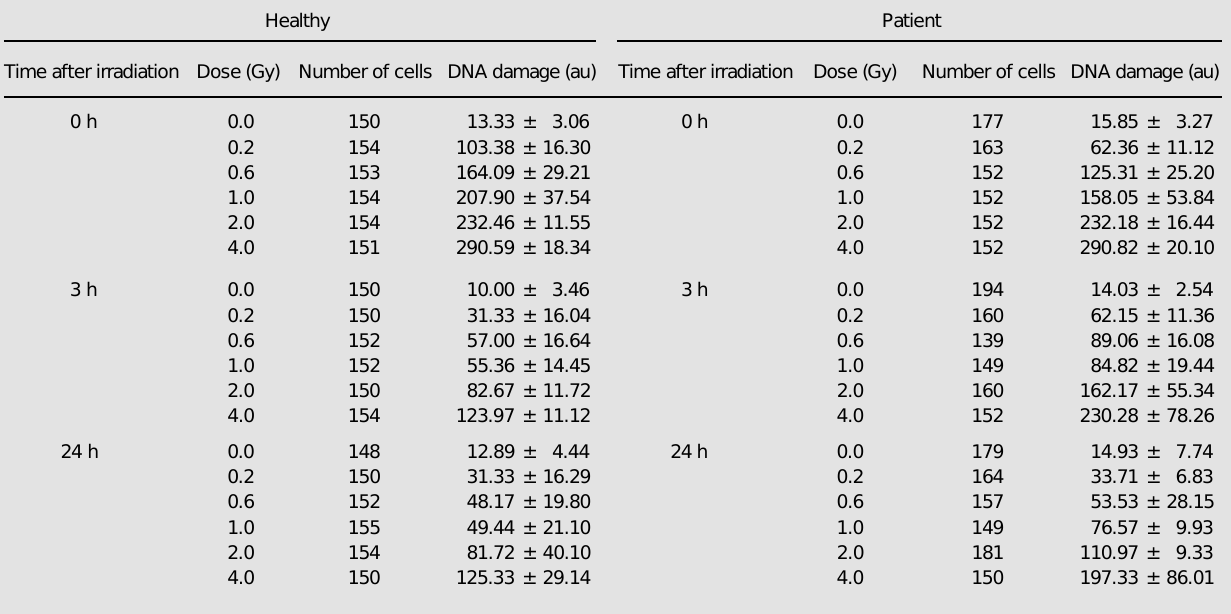
Table 4 - Mean values of DNA damage obtained for blood samples from 3 healthy donors and 3 breast cancer patients, processed immediately or 3 and 24 h after in vitro exposure to 60 Co. Healthy